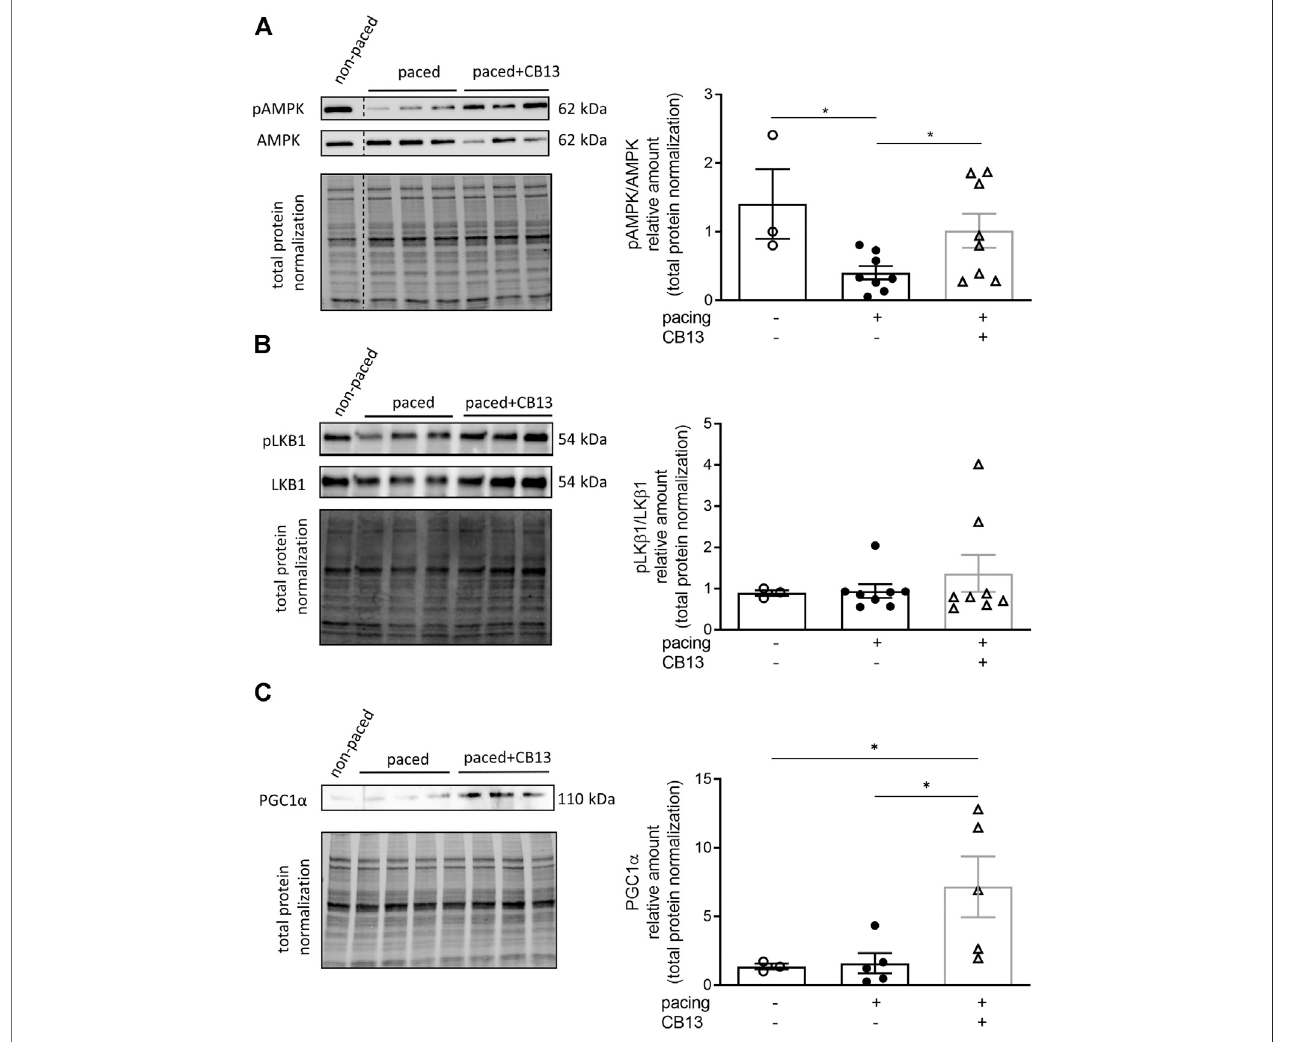
FIGURE 5 | Tachypacing induced reduction of phosphorylated AMPK, while CB13 treatment abrogated tachypacing effects and increased PGC1 α signaling. (A) Tachypacing for 1.5 h signi fi cantly reduced pAMPK compared to non-paced atrial tissue, while CB13 perfusion during tachypacing rescued pAMPK. (B) pLKB1 levels did not change between groups. (C) Protein expression levels of PGC1 α were unaltered in both non-paced and tachypaced atrium whereas CB13 perfusion during tachypacingsigni fi cantlyupregulated PGC1 α .* p ≤ 0.05. n (cid:1) 3 – 8.Datapresented asmean ± SEM.Datawastested fornormalityusing Shapiro-Wilknormality test. Accordingly, statistical analysis was performed by one-way ANOVA with Holm-Sidak post-hoc for multiple comparisons (A, C) and by Kruskal-Wallis with Dunn ’ s post- hoc for multiple comparisons (B) .